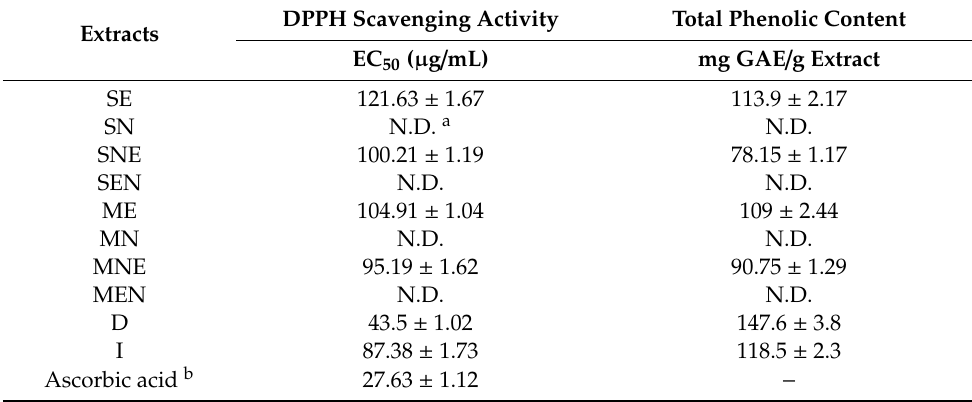
Table 1. DPPH free radical scavenging activities of Thymus sipyleus Boiss. subsp. rosulans (Borbas) Jalas (TS) extracts expressed as EC 50 values and total amount of phenolic